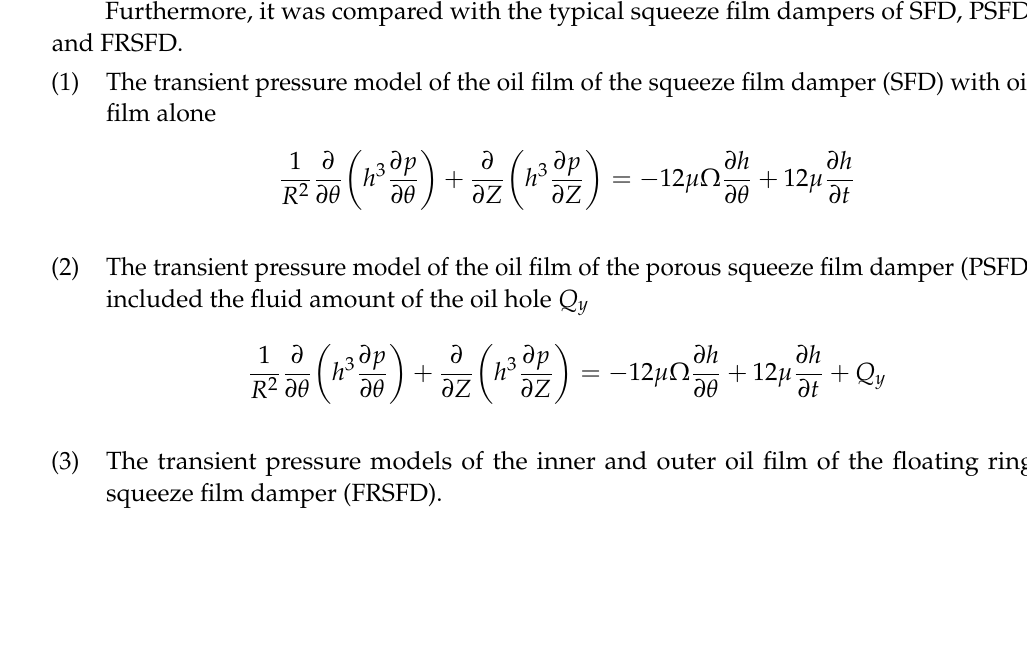
The transient pressure model of the oil film of the porous squeeze film damper (PSFD) included the fluid amount of the oil hole Q y